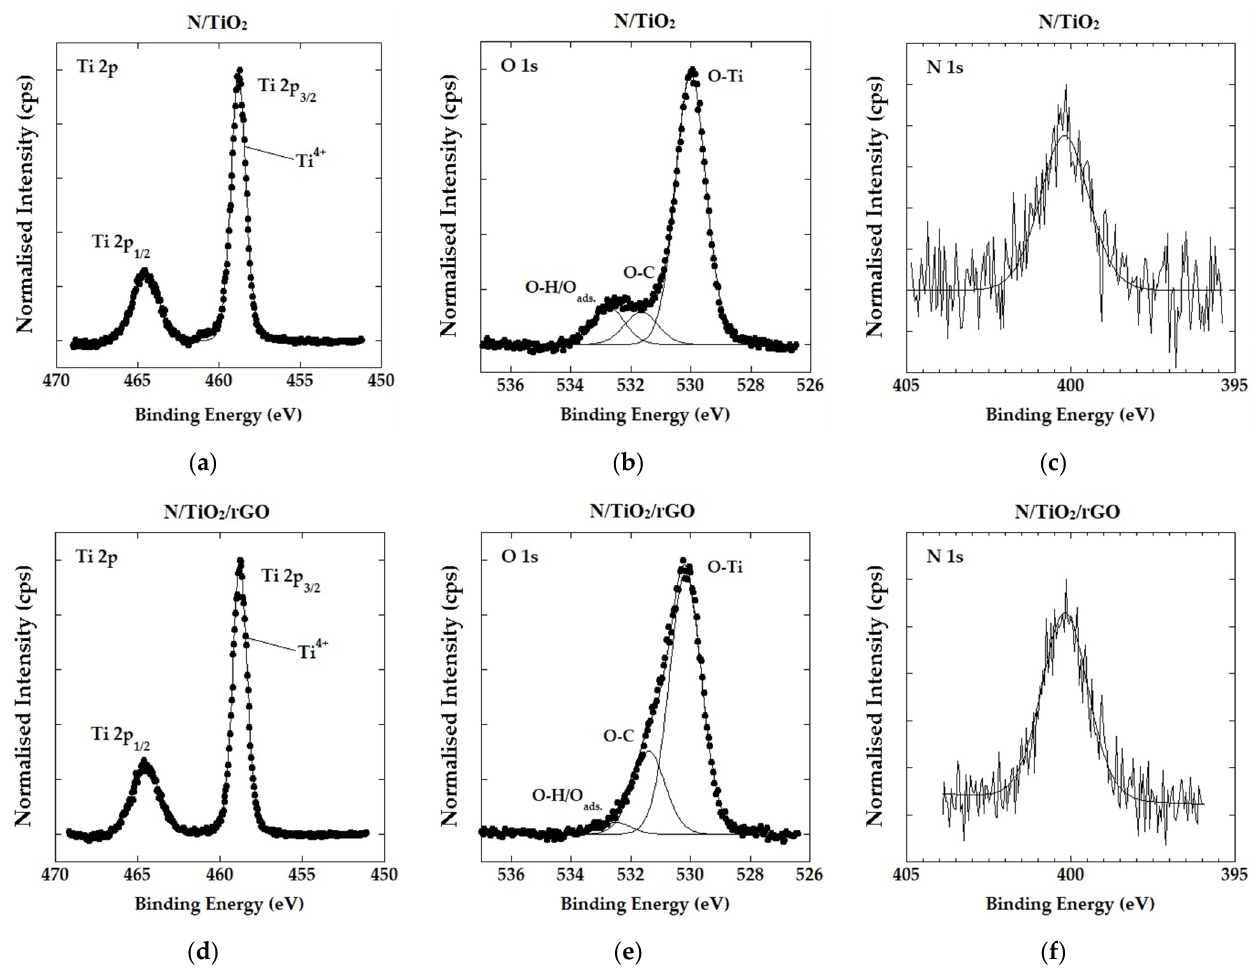
Figure 3. High-resolution XPS spectra of N/TiO 2 and N/TiO 2 /rGO with 0.25 wt. % of rGO. ( a – c ) are the Ti 2p spectrum, O 1s spectrum, and N 1s spectrum, respectively, for N/TiO 2 . ( d – f ) are the Ti 2p spectrum, O 1s spectrum, and N 1s spectrum, respectively, for N/TiO 2 /rGO.